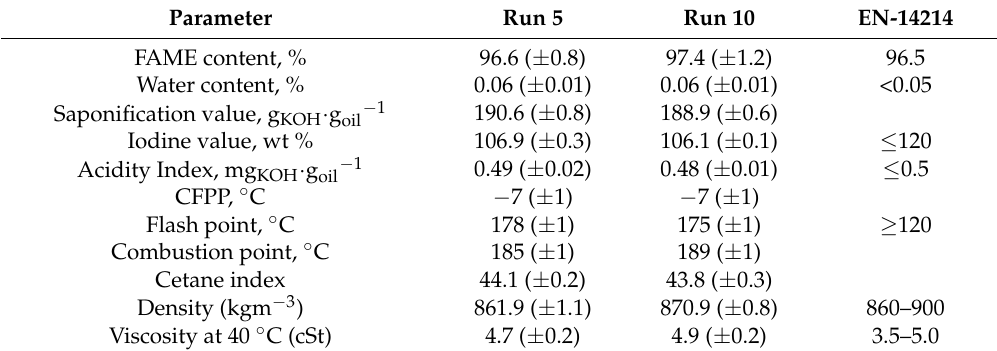
Table 3. Properties of biodiesel produced from rapeseed oil in the best conditions of this